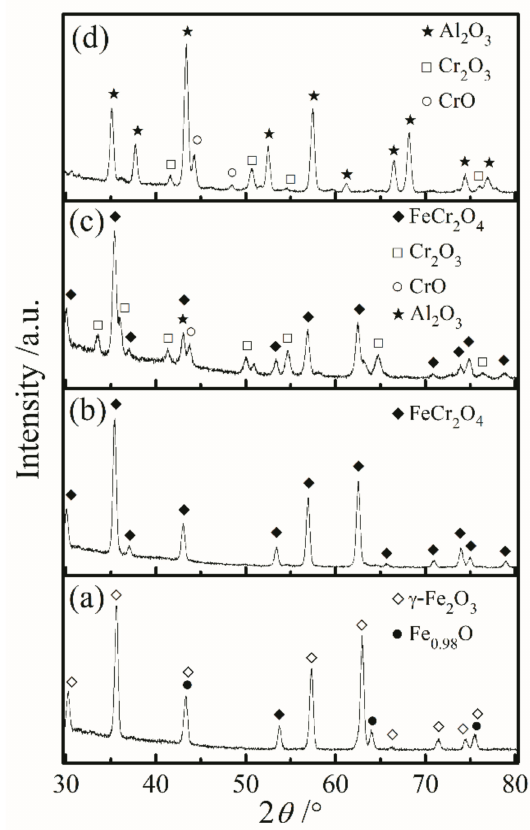
Figure 5. XRD patterns of oxide scales on the steels with ( a ) 0, ( b ) 1.76, ( c ) 3.45, and ( d ) 5.34 wt% Al. The steels were oxidized at 1100 ◦ C for 480